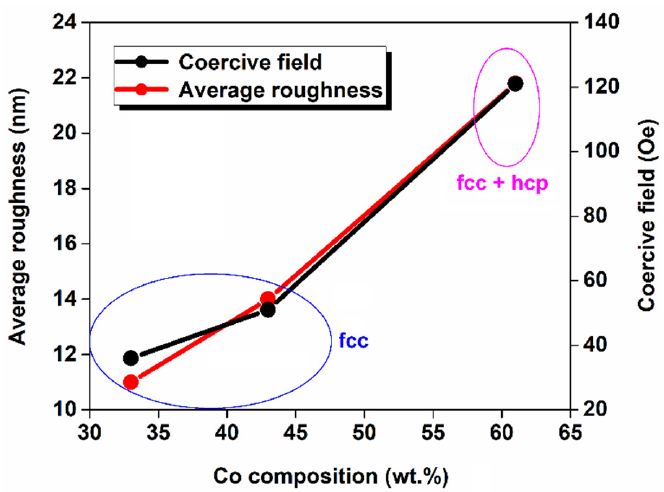
Figure 8. The correlation between the coercive field and the surface roughness.